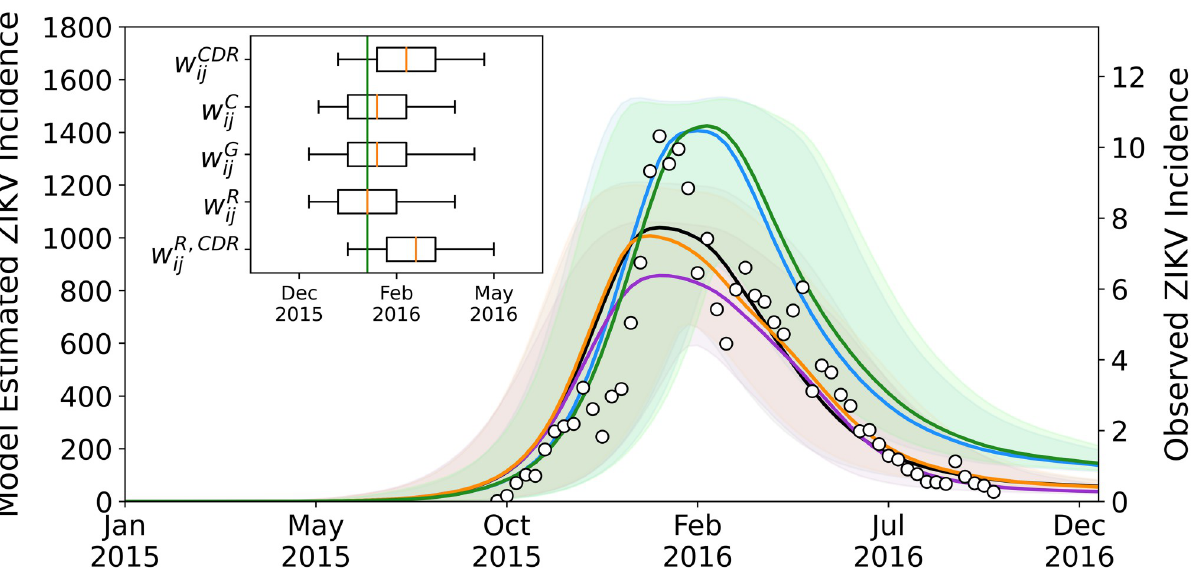
Fig 5. Comparison between the estimated and observed ZIKV incidence. Weekly number of new ZIKV infections (per 100,000 population) as estimated from the stochastic ensemble output in the setting using the CDR-informed network (blue), the census network (black), the gravity network (orange), the radiation network (purple), and the radiation network calibrated on the CDR-informed mobility (green). The bold line and shaded area refer to the median number of infections and 95% CI of the model estimates. Black dots correspond to the official ZIKV incidence (per 100,000 population) reported by Colombia’s National Institute of Health (right y-axis). For ease of comparison, surveillance data is scaled on the peak of the model estimates of the CDR-informed network. The inset graph shows the peak week as calculated from the model estimates. The observed epidemic peak was in week 2016–05 (green